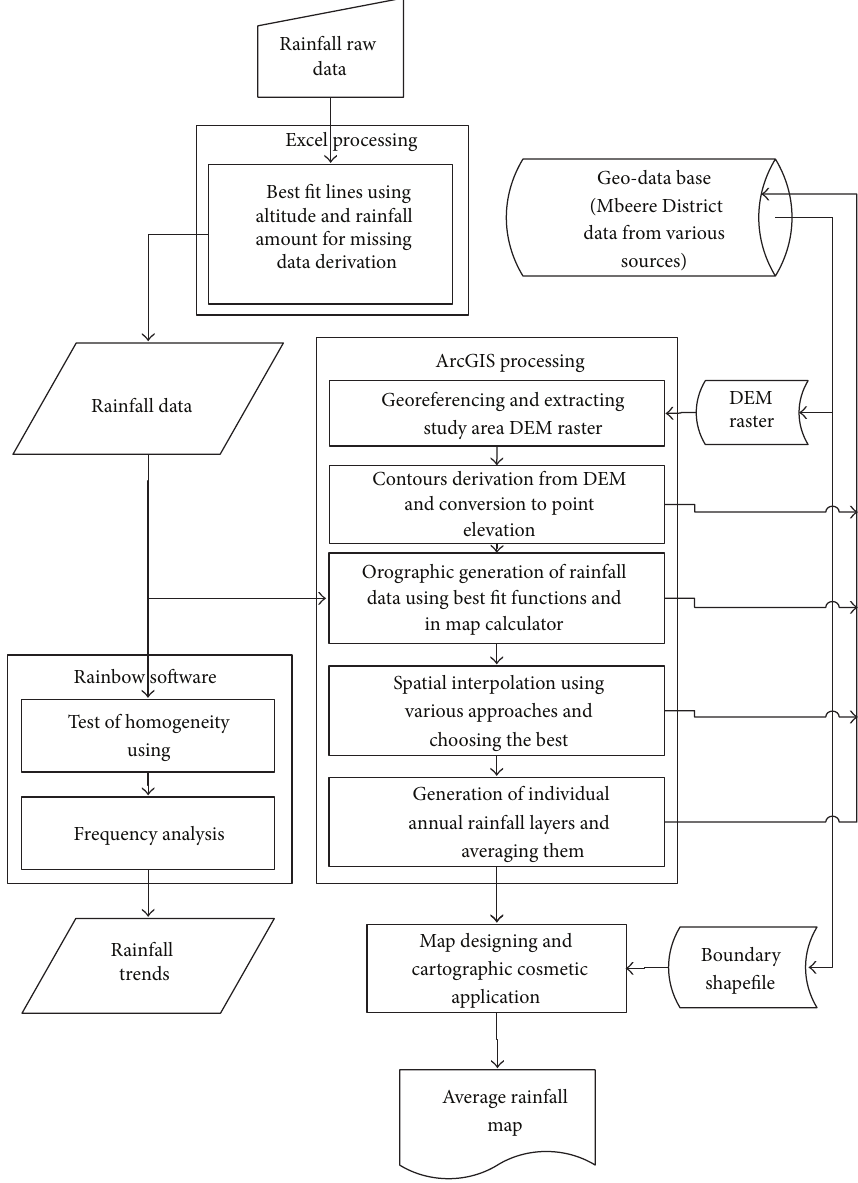
Figure 2: Flow chart showing stepwise interpolation and data reconstruction analyses. Table 2: Mean, standard deviation, and 𝑅 2 values for the rainfall dailies from study stations for the period between 2001 and 2013.